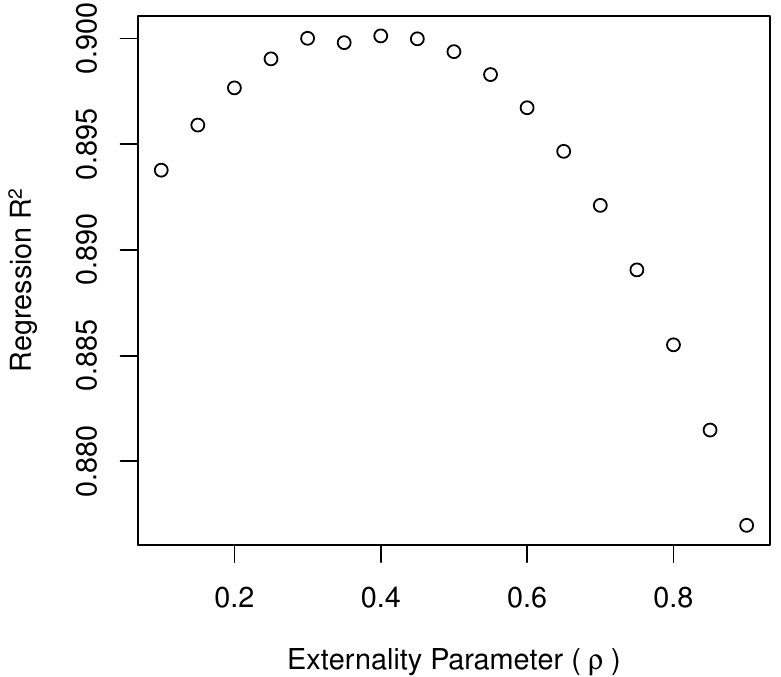
Figure A3. R 2 as a function of the negative externality parameter. (This figure illustrates the development of the goodness-of-fit of the overall regression in terms of R 2 derived from Equation (15) based on various levels of the global negative externality parameter ρ . With a negative externality parameter of 0.65, the effect of the floor to area ratio ( FAR ) on land prices is decreasing. Therefore, the graph demonstrates negative externalities caused by the FAR